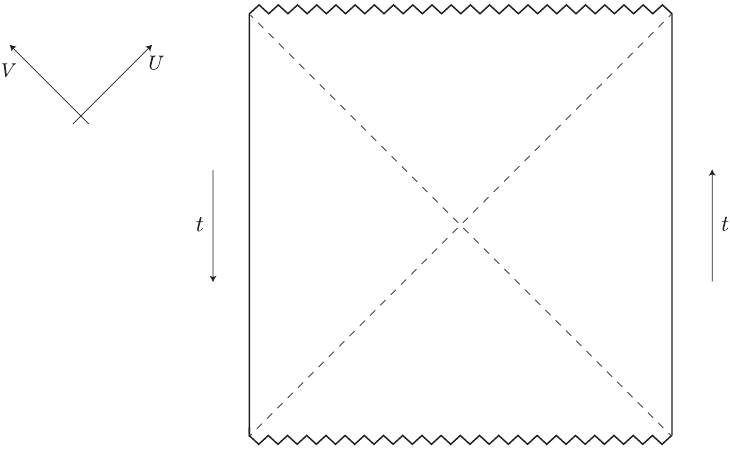
Figure 1. Penrose diagram for the BTZ black